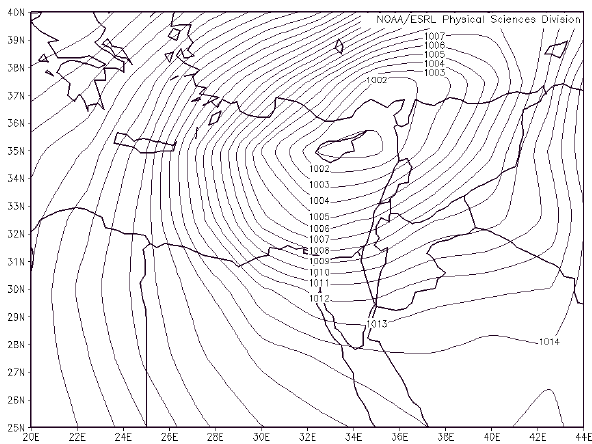
Fig. 2. Typical synoptic setting of Cyprus low in the EM, 29 Jan- uary 2008. Mean sea level pressure isobars are displayed and la- beled inhPa units. Image provided by the NOAA/OAR/ESRL PSD, Boulder, Colorado, USA, from their Web site at http://www.esrl.